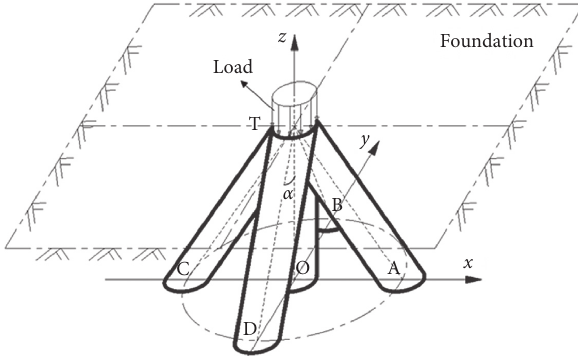
Figure 3: The stress field constructed by 5 stress columns.